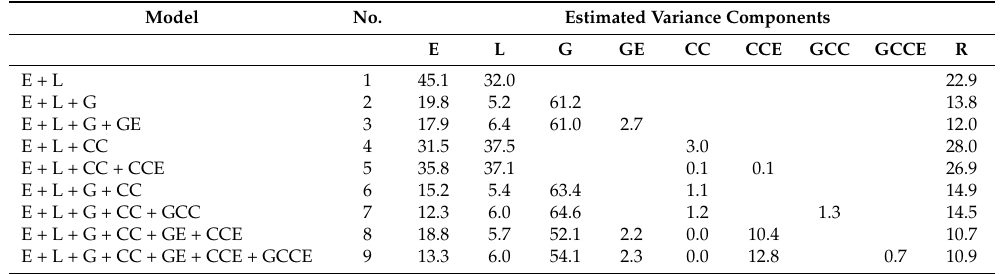
Table 2. Estimated variance components for the nine models for days to